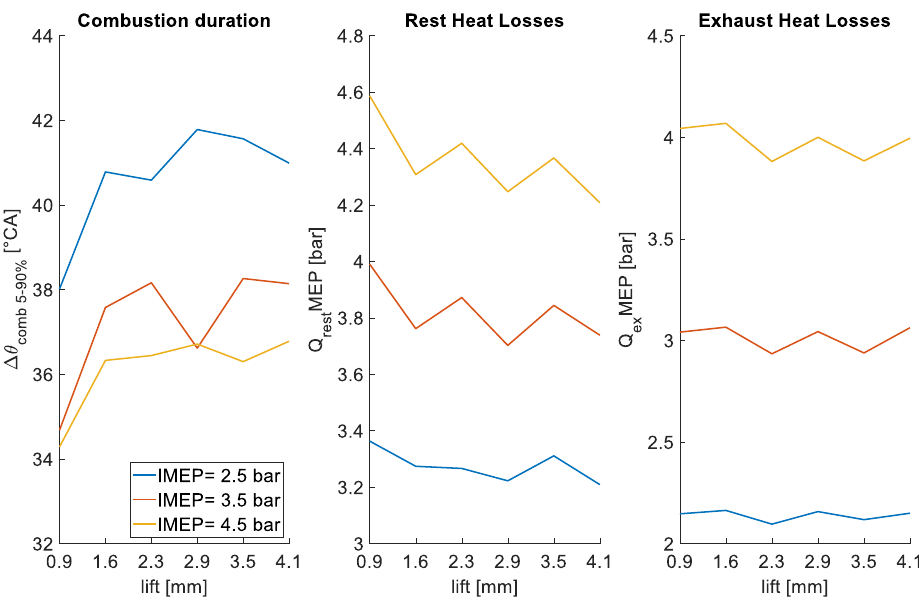
Figure 9. Influence of intake valve lift on Willans efficiency.